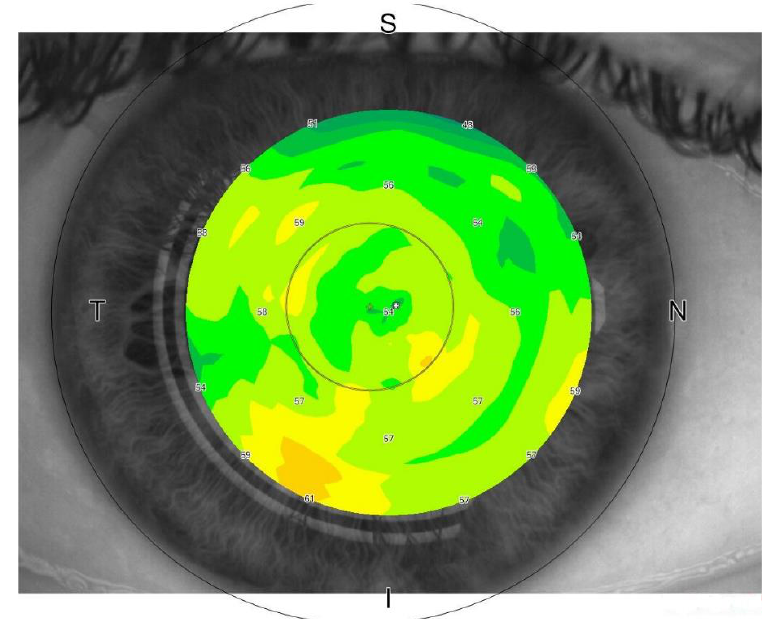
Figure 6. Swept-source (SS) optical coherence tomography (OCT) imaging of the corneal epithelium thickness. The thickness of the corneal epithelium can be accurately quantified by OCT imaging at the central vertex and in the peripheral zones. (Sectors were as follows: N: nasal; T: temporal; S: superior; I: inferior). Reflectivity of the en-face OCT image indicates the corneal epithelial thickness (low intensity (dark blue) ≤ 25 μm to high intensity (red/white) ≥ 85 μm).